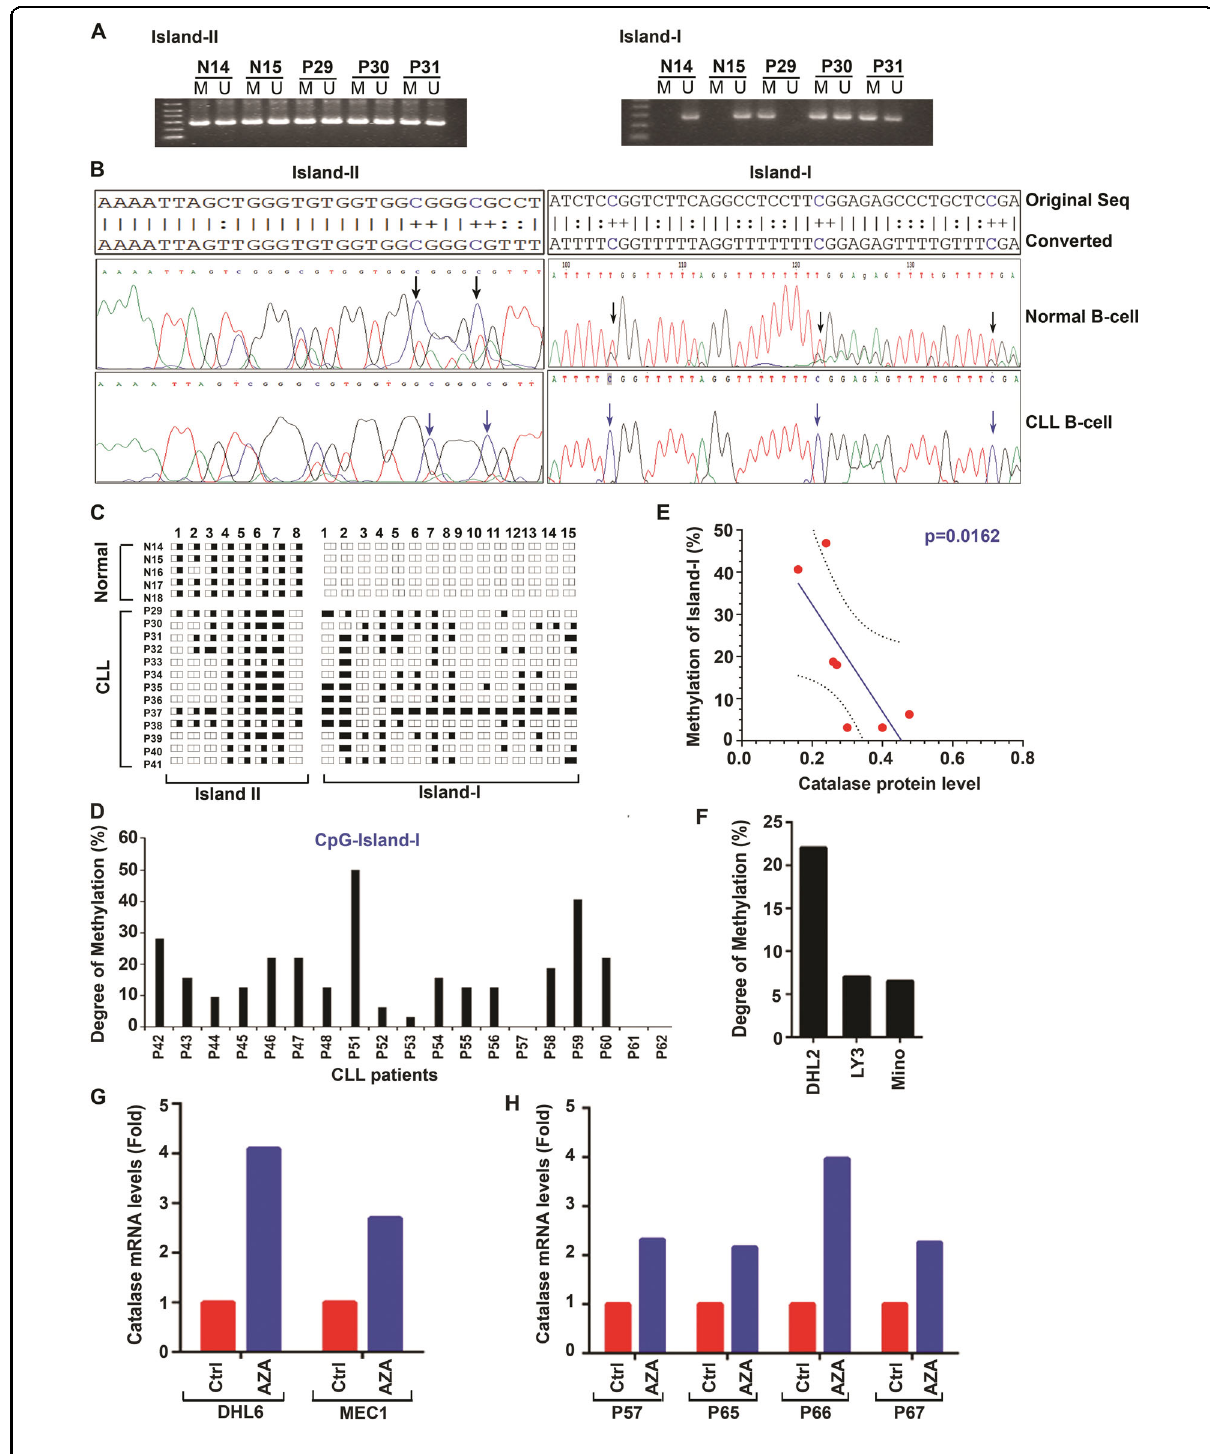
Fig. 4 (See legend on next